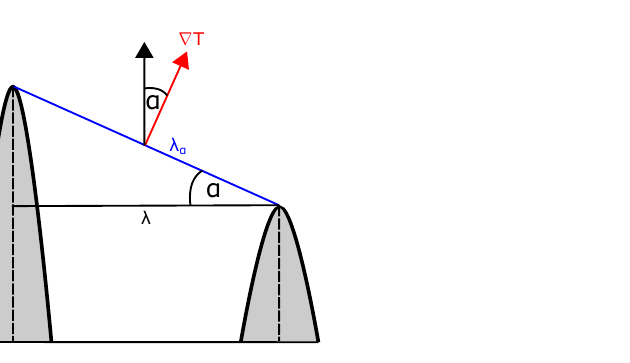
Figure A5. Effective dendrite arm spacing λ α based on the orientation of the dendrite and local temperature gradient ∇ T